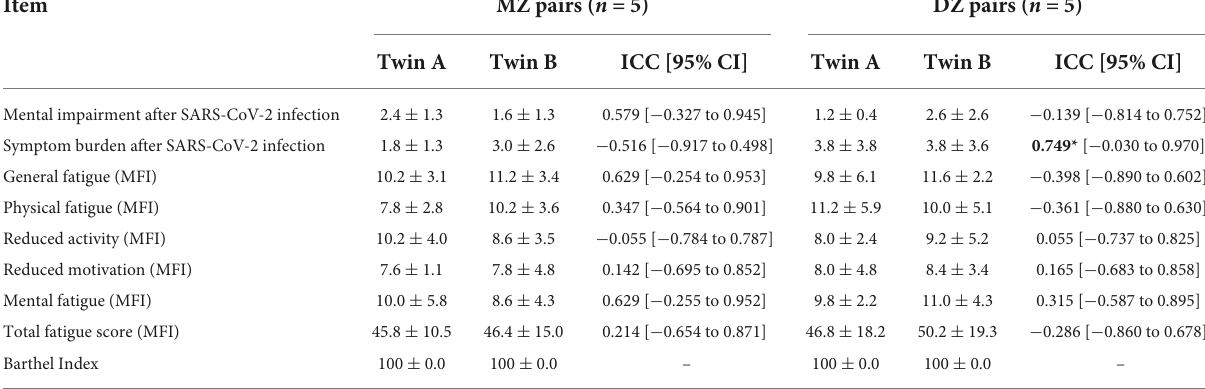
TABLE 3 Impairments related to SARS-CoV-2 infection in MZ and DZ twin pairs (reported as mean ± standard deviation) and intra-class correlations (reported as ICC coefficients and 95% CI). Item MZ pairs ( n = 5) DZ pairs ( n = 5) Twin A Twin B ICC [95% CI] Twin A Twin B ICC [95% CI]